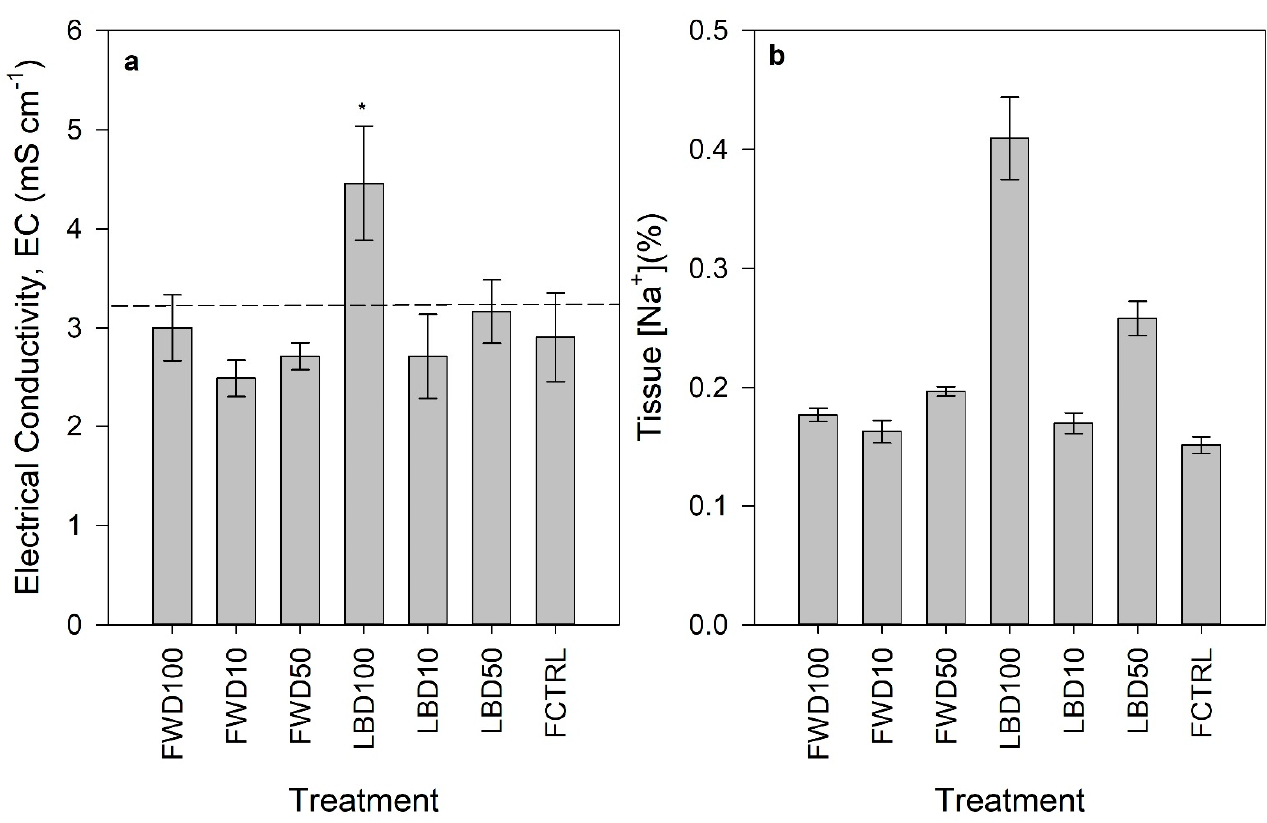
Figure 6. Digestate treatment effects on planting media electrical conductivity (EC) ( a ) and kai choy tissue [Na+] ( b ). Error bars represent the standard error of the mean ( n = 5). The dash line in panel (a) represents the EC threshold of 3.2 mS cm − 1 for kai choy, and the asterisk shows a significant difference ( p < 0.05) between mean EC in the LBD100 treatment, as compared with the fertilizer control. Means that share the same letter in panel (b) are not significantly different from each other ( p < 0.05).